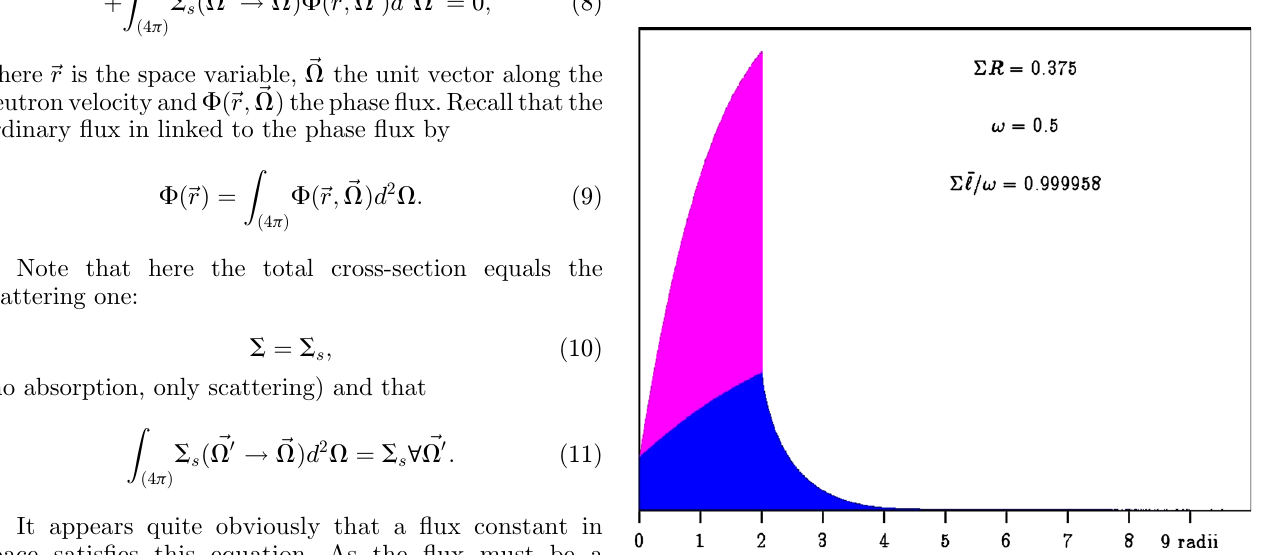
Fig. 2. Distribution of the lengths travelled by the particles for a sphere of opacity